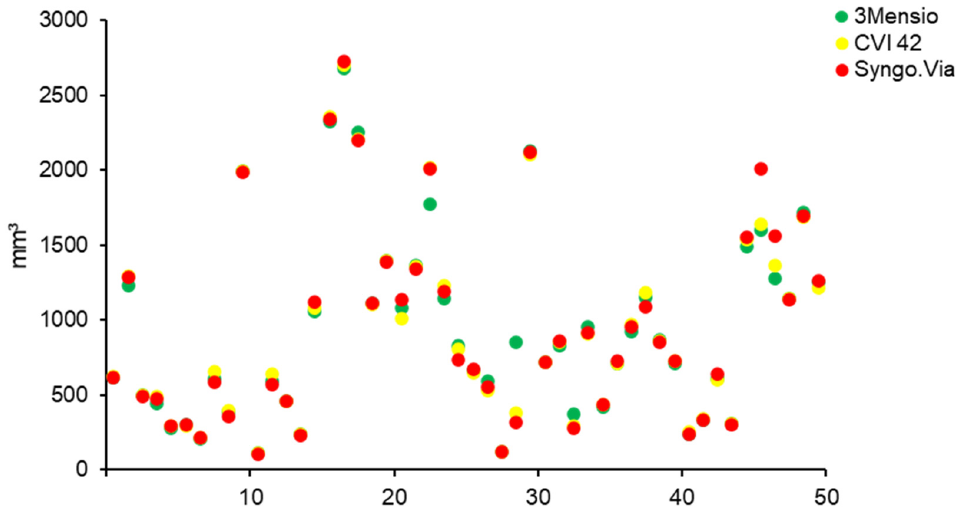
Figure 2. AVC calculation using three software solutions. A comparison of AVC measured in a cohort of 50 patients, using three different software types. There was no significant difference in AVC (Friedmann test for continuous data with devi- ations from normality; p = 0.455). AVC: aortic valve calcification.